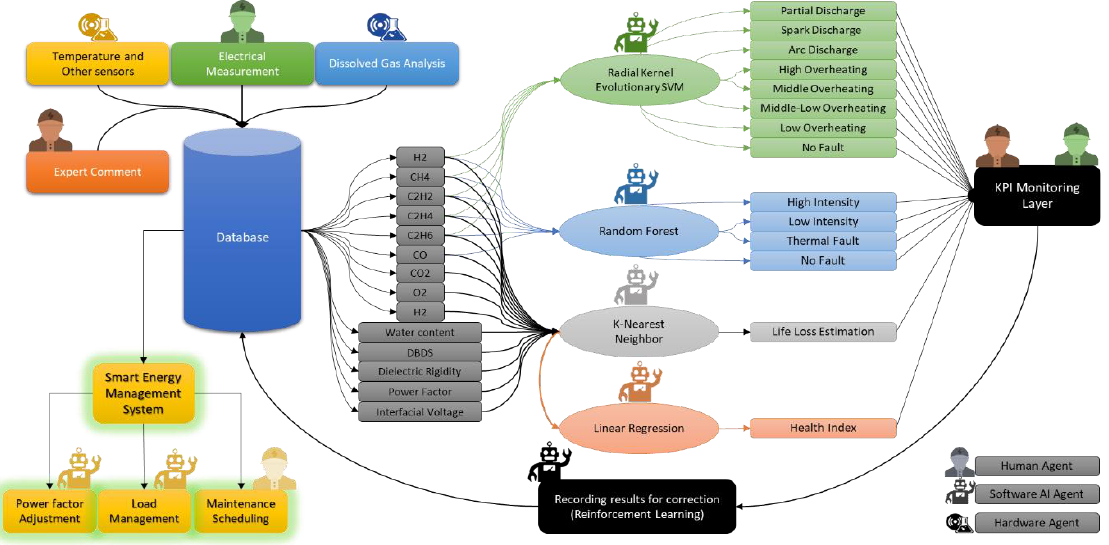
Figure 16. Multi agent interactions in the proof-of-concept architecture.